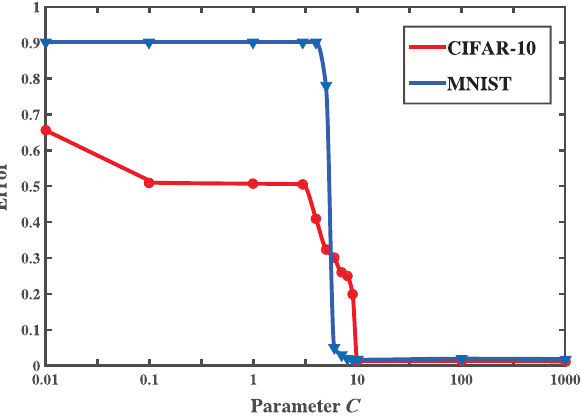
Fig. 3 Impact of penalty parameter C on